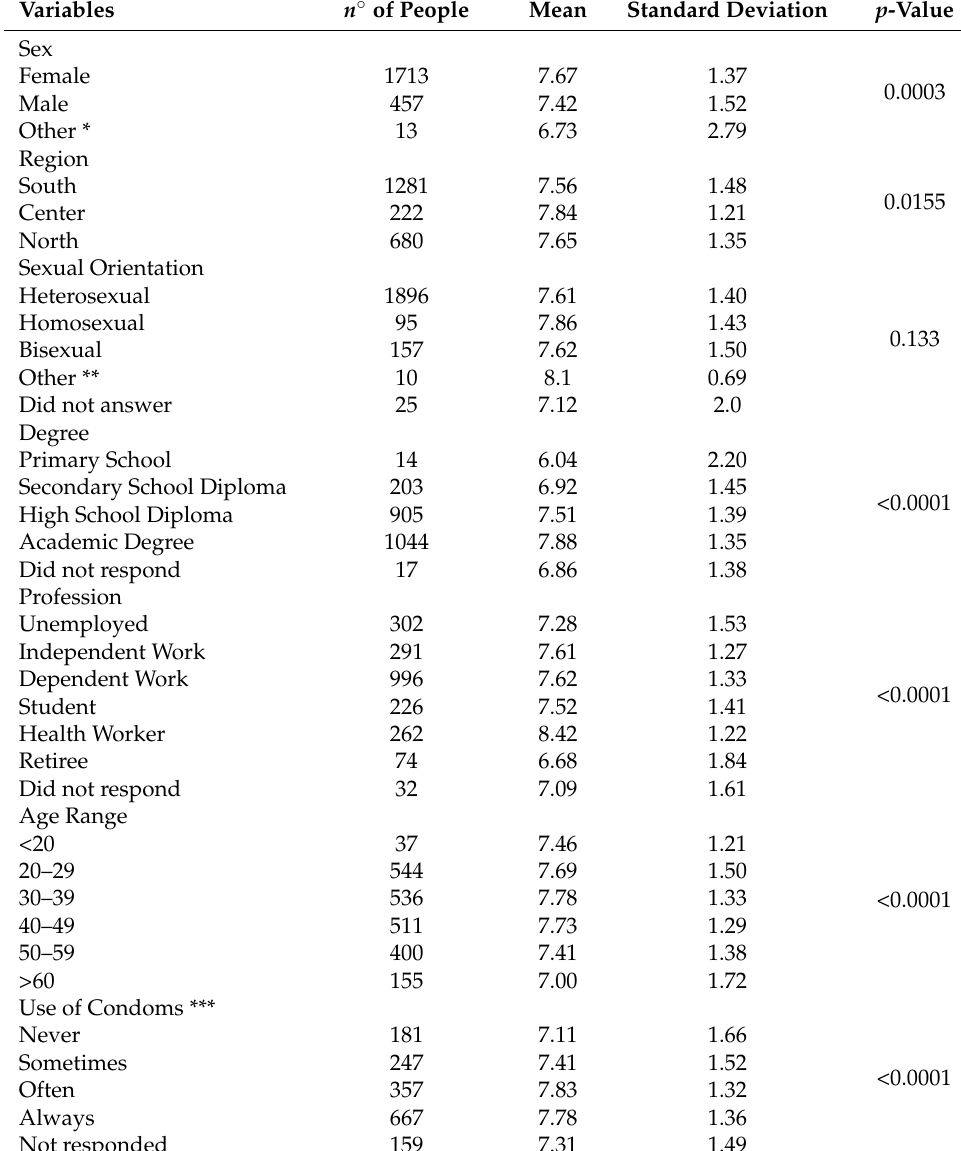
Table 1. Characteristics of 2183 patients that participated in the survey about HIV and STIs, and the mean ( ± SD) of the